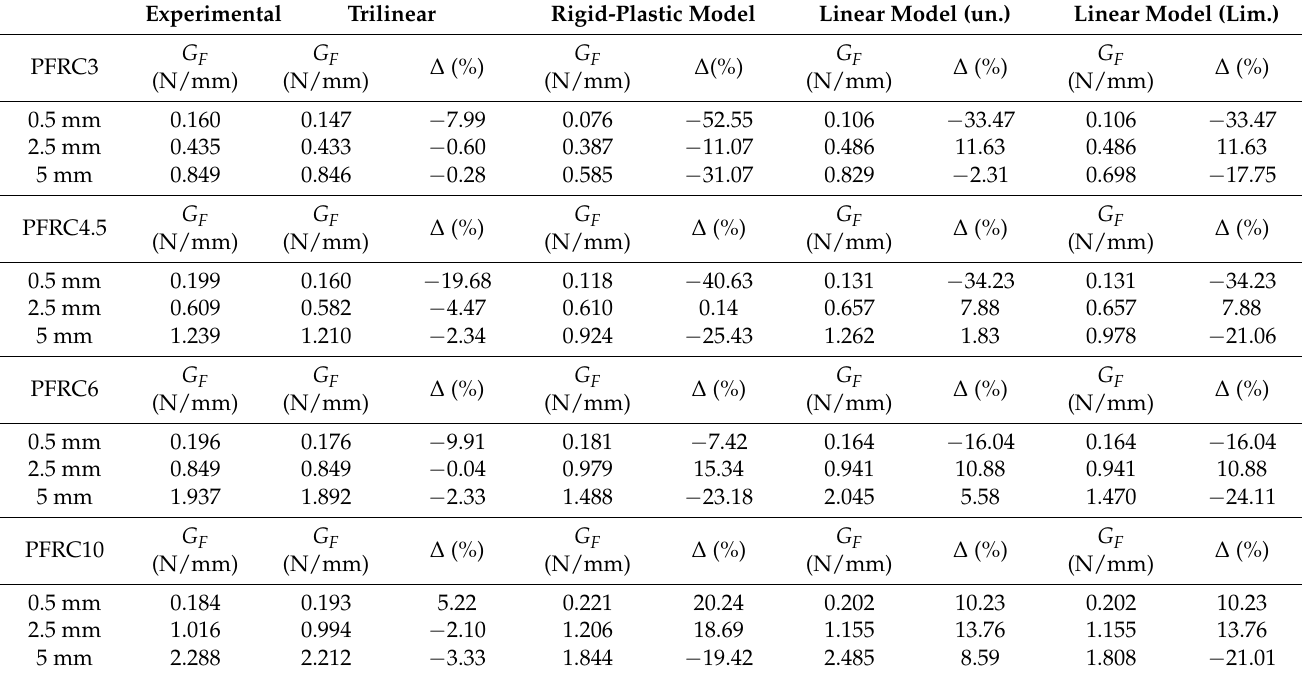
Table 3. Fracture energy consumption in the experimental tests and in the simulations. Experimental Trilinear Rigid-Plastic Model Linear Model (un.) Linear Model